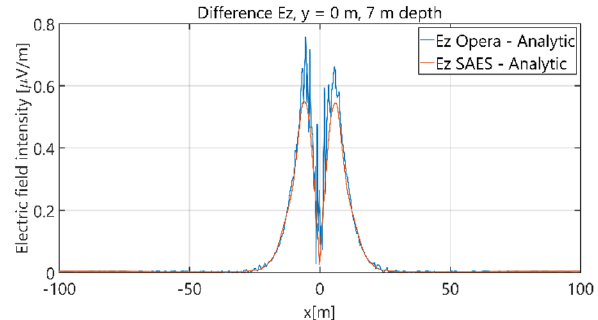
Figure 28. Distribution of differences between E z values obtained from Opera (FEM) and SAES (BEM) models and the analytical model ( y = 0 m, z = − 7 m, case II).